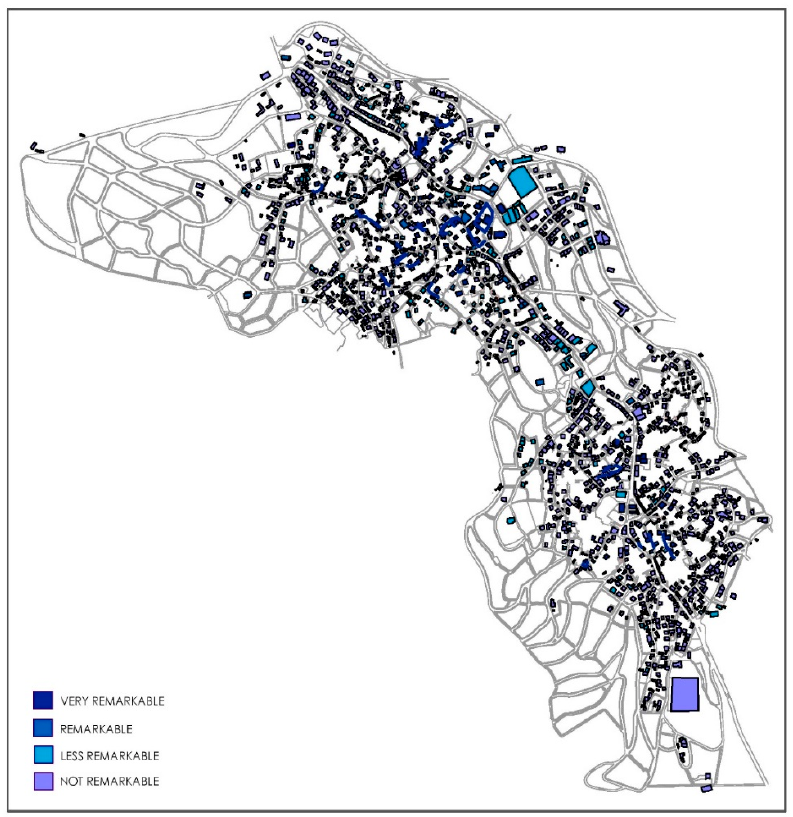
Figure 13. Evaluation map.